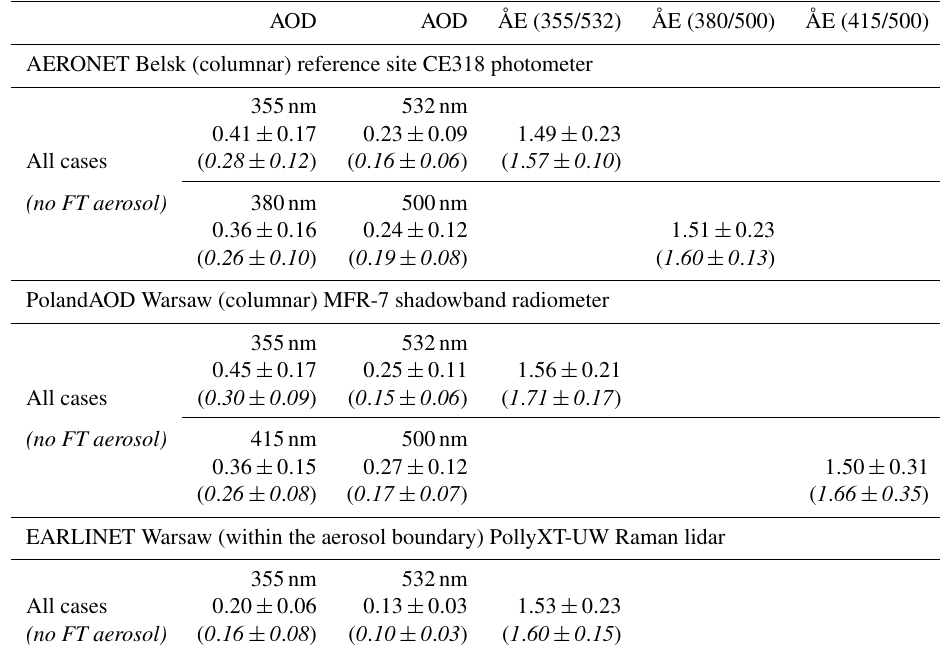
Table 3. The mean daytime (03:00–19:00UTC) aerosol optical depth (AOD) and Ångström exponent (ÅE) with standard deviations derived within the atmospheric boundary layer at 355 and 532nm from the PollyXT lidar at the EARLINET site, Warsaw, and in atmospheric column measured by the MFR-7 shadowband radiometer (415 and 500nm) at the PolandAOD-NET site, Warsaw. For reference, the mean values derived from Version 3 Level 2.0 CE318 CIMEL (380 and 500nm) at the AERONET site in Belsk are given. The AOD CL of the CE318 and the MFR-7 were scaled to the lidar wavelength (355 and 532nm respectively) using the Ångström power law. The mean values were obtained for July–September of 2013, 2015, and 2016, when instruments operated simultaneously (41 cases). The mean values derived for cases with no aerosol in the free troposphere (12 cases), as given in EARLINET/ACTRIS database, are shown in parentheses and emphasized using italic